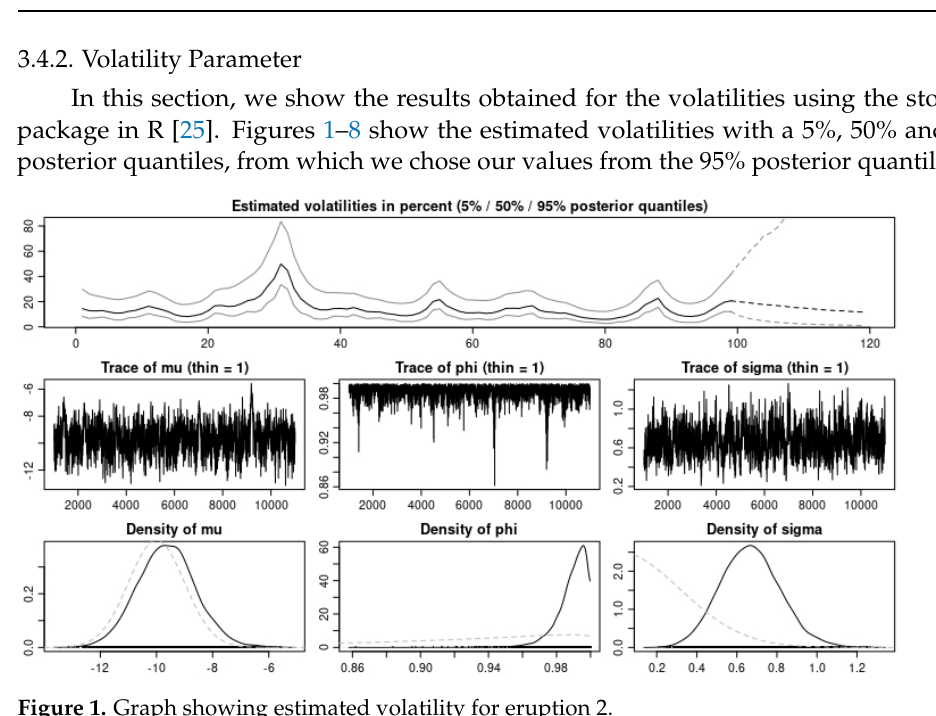
Figure 1. Graph showing estimated volatility for eruption 2.